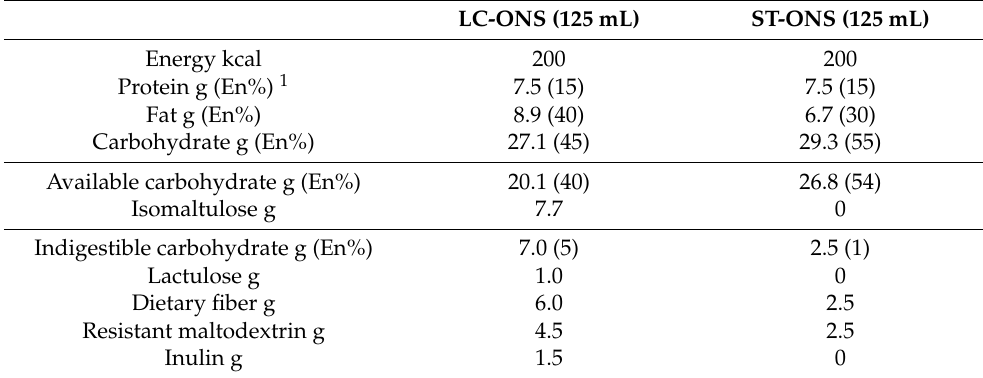
Table 1. Composition of the test